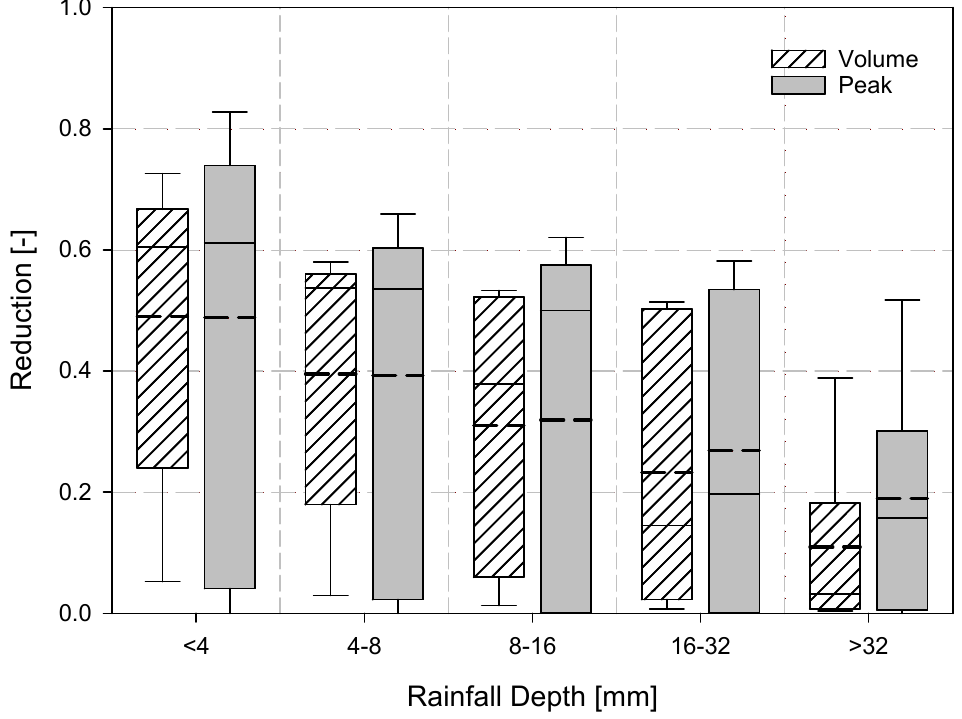
Figure 5. Non ‐ parametric distribution of the volume (hatched box) and peak (grey box) reduction rates simulated at the catchment scale for each class of the rainfall depth. The solid and dashed lines within the box mark indicate the median and mean values respectively.